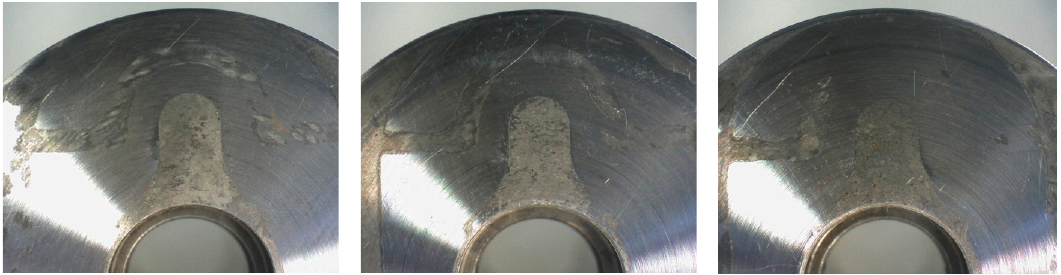
Figure 19. Magnified top view (10×) of the clean pump barrels.